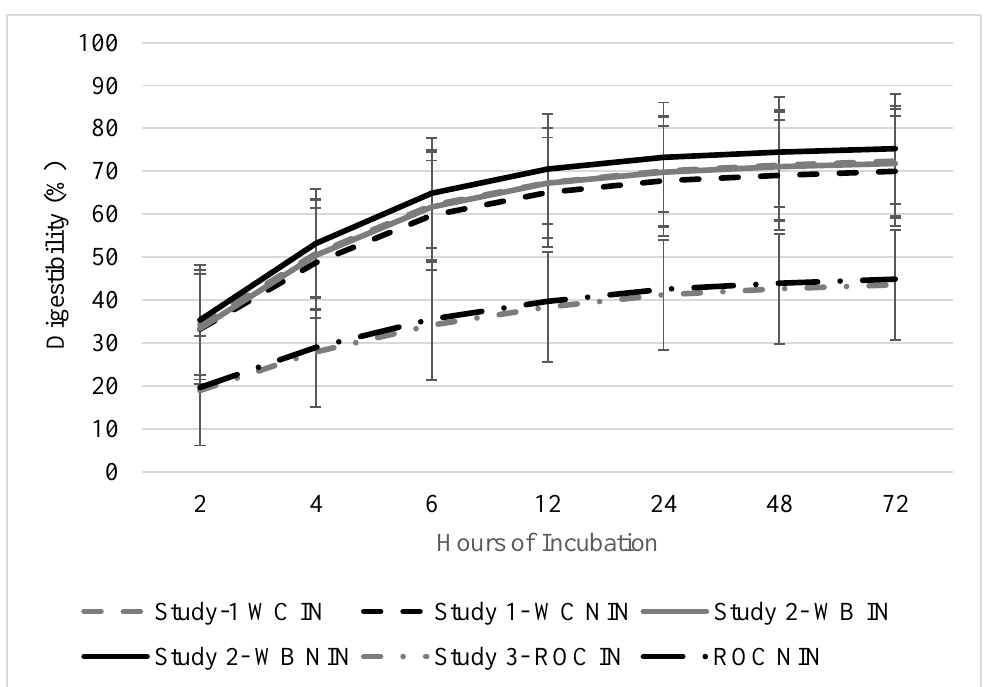
Figure 2. Cumulative digestibility of baleage from annual cool-season forage mixtures ensiled with or without inoculant after up to 72 h ruminal incubation. Study 1 included wheat and crimson clover with inoculant (WC-IN) and without inoculant (WC-NIN). Study 2 included wheat and brassica hybrid with inoculant (WB-IN) and without inoculant (WB-NIN). Study 3 included annual ryegrass, oat, and crimson clover with inoculant (ROC-IN) and without inoculant (ROC-NIN). Error bars indicate standard error of the mean (SEM).